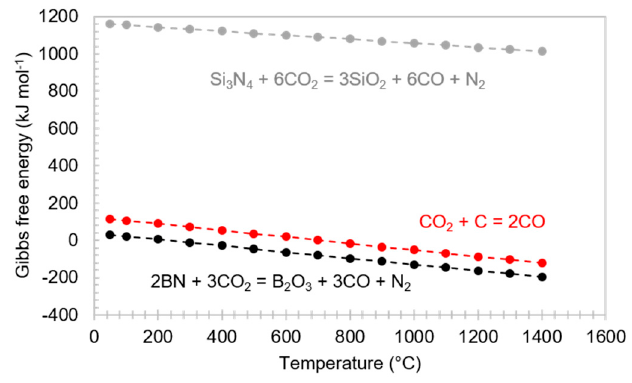
Figure 8. Gibbs free energy for the Boudouard reaction, CO 2 reacting with the boron nitride (BN) and Si 3 N 4 at various temperature.